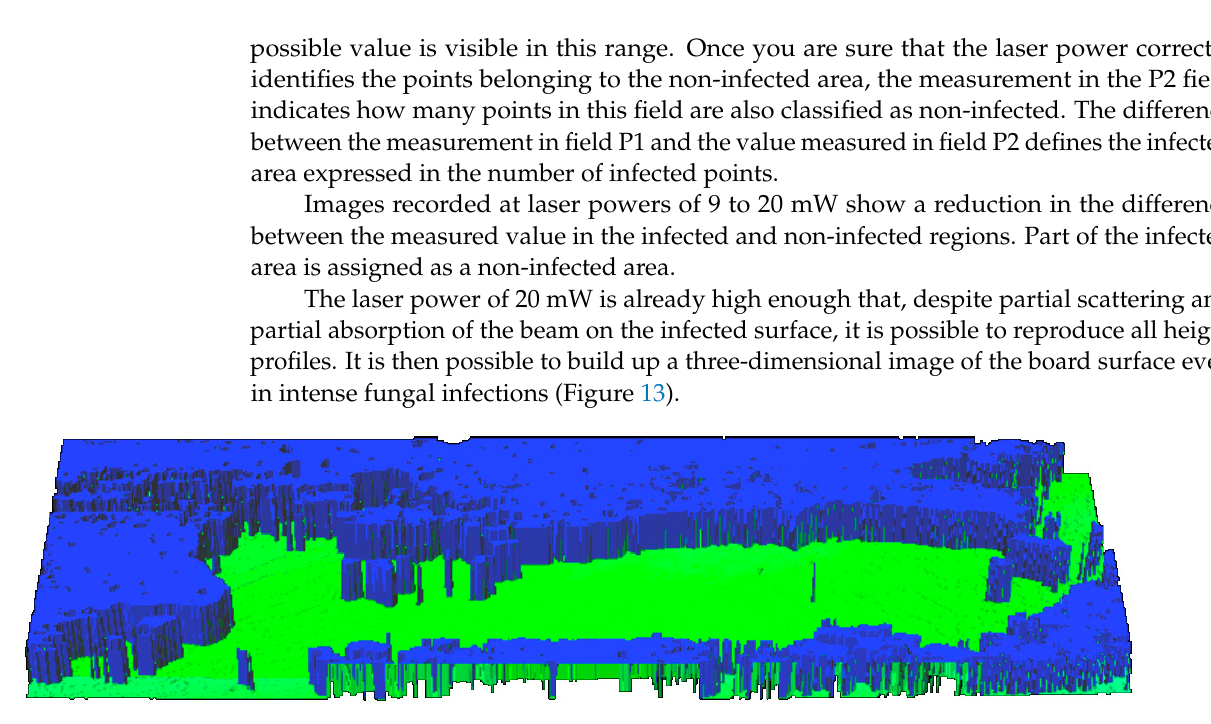
Figure 13. View of the infected area in a 3D image captured with a laser operating power at 7 mW.